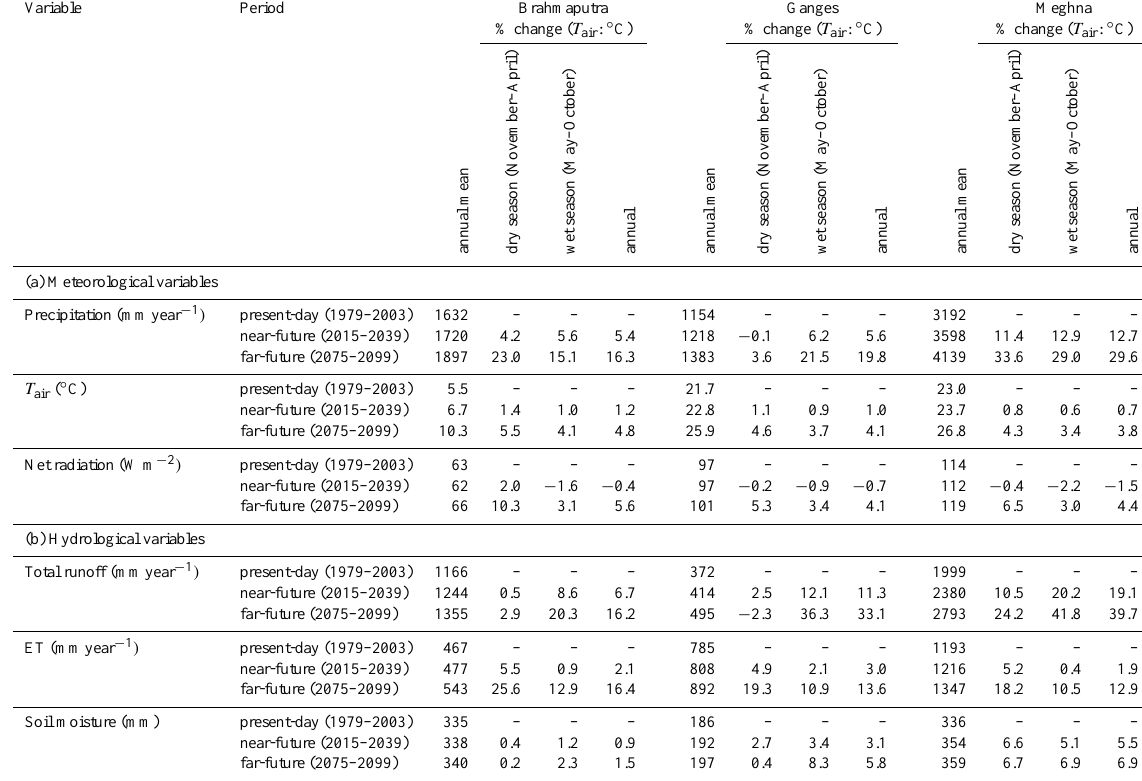
Table 6. The 10-simulation average of annual mean and percentage changes of hydrological and meteorological variables. Variable